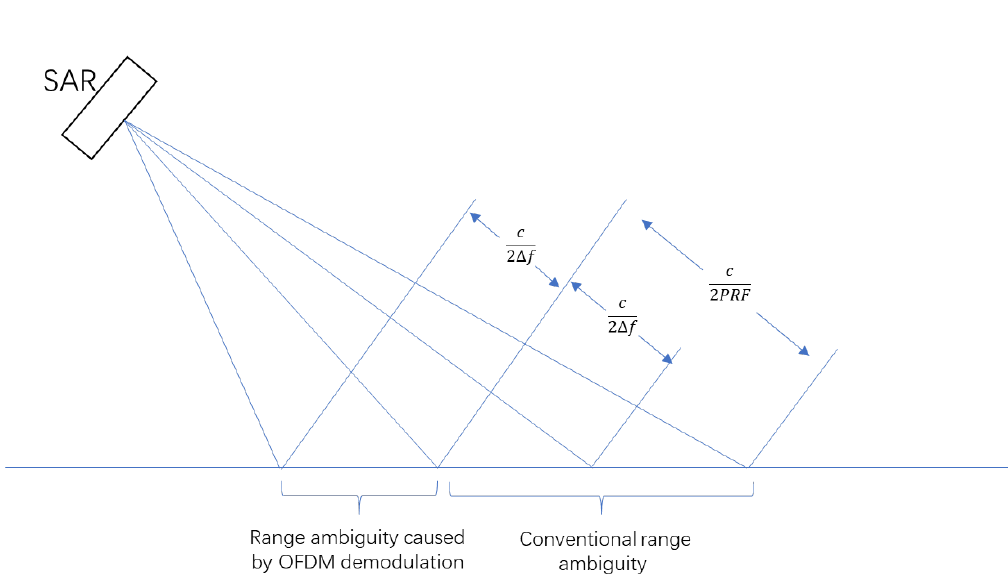
Figure 4. Geometric sketch of range ambiguity.